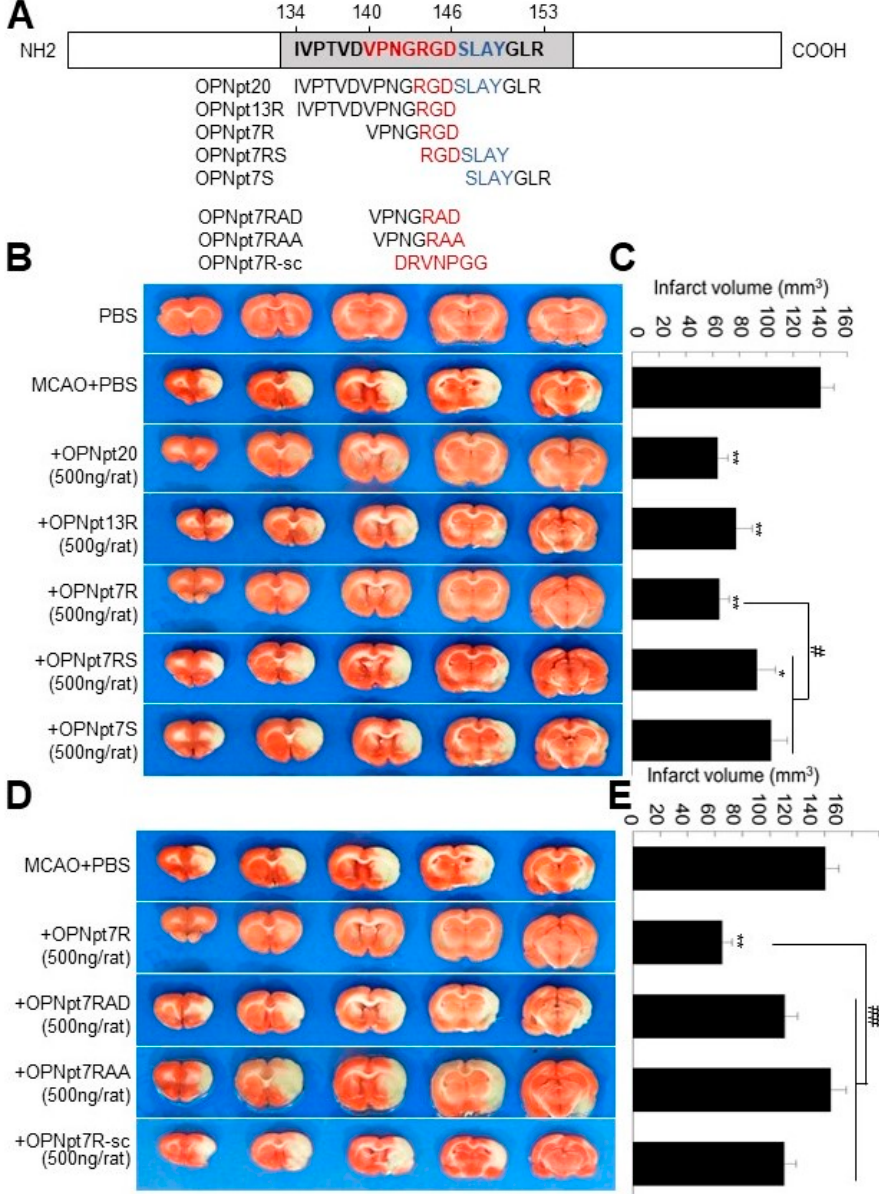
Figure 1. Reduction in infarct volume by intranasally administered OPNpt7R and the importance of the RGD motif; ( A ) schematic diagram presenting the amino acid sequences of OPNpt20, OPNpt13R, OPNpt7R, OPNpt7RS, OPNpt7S, OPNpt7R-RAD, OPNpt7R-RAA, and OPNpt7R-sc. ( B , C ) OPNpt20 (500 ng), OPNpt13R (500 ng), OPNpt7R (500 ng), OPNpt7RS (500 ng), or OPNpt7S (500 ng) was administered intranasally at 1 h post-MCAO (60 min), and TTC staining was performed at 2 days post-MCAO. ( D , E ) OPNpt7R (500 ng), OPNpt7R-RAD (500 ng), OPNpt7R-RAA (500 ng), or OPNpt7R-sc (500 ng) was administered intranasally at 1 h post-MCAO, and TTC staining was performed at 2 days post-MCAO. Representative images of infarctions are shown ( B , D ), and mean infarction volumes are presented as the mean ± SEM ( n = 4–11) ( C , E ). Sham, sham-operated rats; MCAO, PBS-treated MCAO control; OPNpt20, OPNpt20-treated MCAO rats; OPNpt13R, OPNpt13R-treated MCAO rats OPNpt7R, OPNpt7R-treated MCAO rats, OPNpt7RS, OPNpt7RS-treated MCAO rats, OPNpt7S, OPNpt7S-treated MCAO rats, OPNpt7R-RAD, OPNpt7R-RAD-treated MCAO rats, OPNpt7R-RAA, OPNpt7R-RAA-treated MCAO rats, OPNpt7R-sc, scrambled OPNpt7R-treated MCAO rats. * p < 0.05, ** p < 0.01 vs. PBS-treated MCAO control, # p < 0.05, ## p < 0.01 between indicated